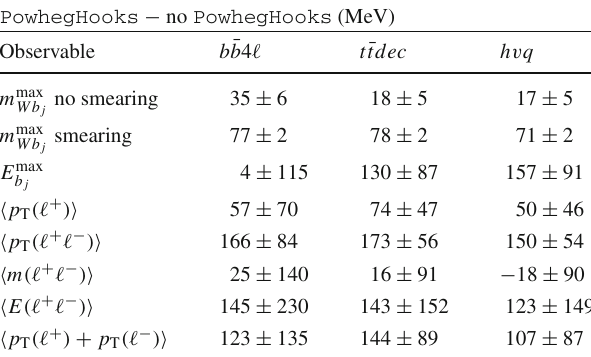
Table 25 Differences between the predictions obtained using the POWHEG:veto = 1 and the POWHEG:veto = 0 settings for the three generators interfaced with